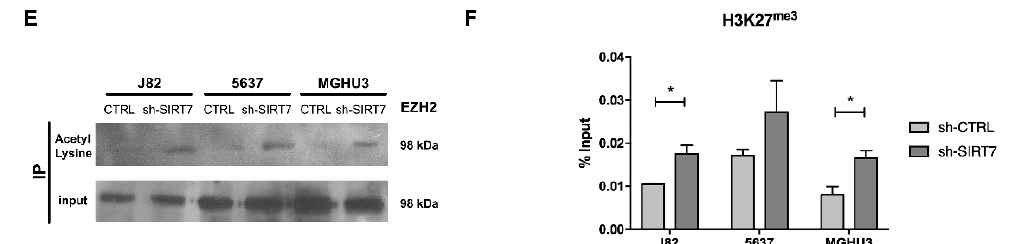
Figure 5. SIRT7 downregulation associates with E-Cadherin repression mediated by histone methyltransferase EZH2. Characterization of EZH2 gene expression in the bladder cancer and normal mucosae cohort ( A ), and in non-muscle invasive and muscle-invasive bladder cancer cases ( B ), by quantitative RT-qPCR. Characterization of EZH2 protein expression ( C ) in 5637 sh-CTRL and sh-SIRT7 cells, by western blot analysis. Proximity Ligation Assay for assessment of interaction of Histone 3 with Histone 3 lysine 27 tri-methylation (H3K27 me3 ) and EZH2 with SIRT7, in 5637 sh-scramble and sh-SIRT7 cells (100× magnification) ( D ). Western blot analysis for EZH2 protein, after co-immunoprecipitation assay with acetyl-lysine antibody in J82, 5637 and MGHU3 sh-scramble/CTRL and sh-SIRT7 cells ( E ). Chromatin immunoprecipitation results for H3K27me3 deposition across the CDH1 gene promoter, in MGHU3, 5637 and J82 sh-scramble/CTRL and sh-SIRT7 cells ( F ). * p < 0.05, ** p < 0.01, *** p < 0.001 and **** p < 0.0001.